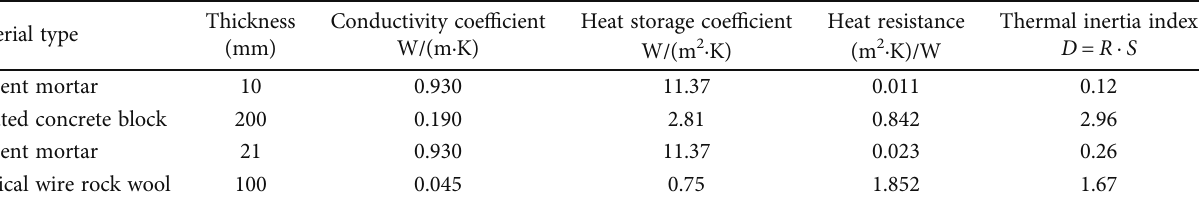
Figure 1: Schematic diagram of heat recovery type of heat storage wall. Table 1: Physical property parameters of each layer of the enclosure wall.